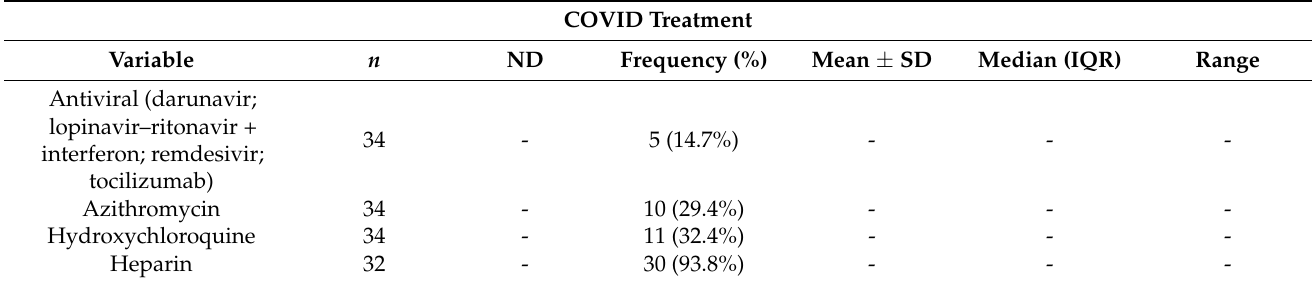
Table 2. COVID treatment and descriptive statistics.